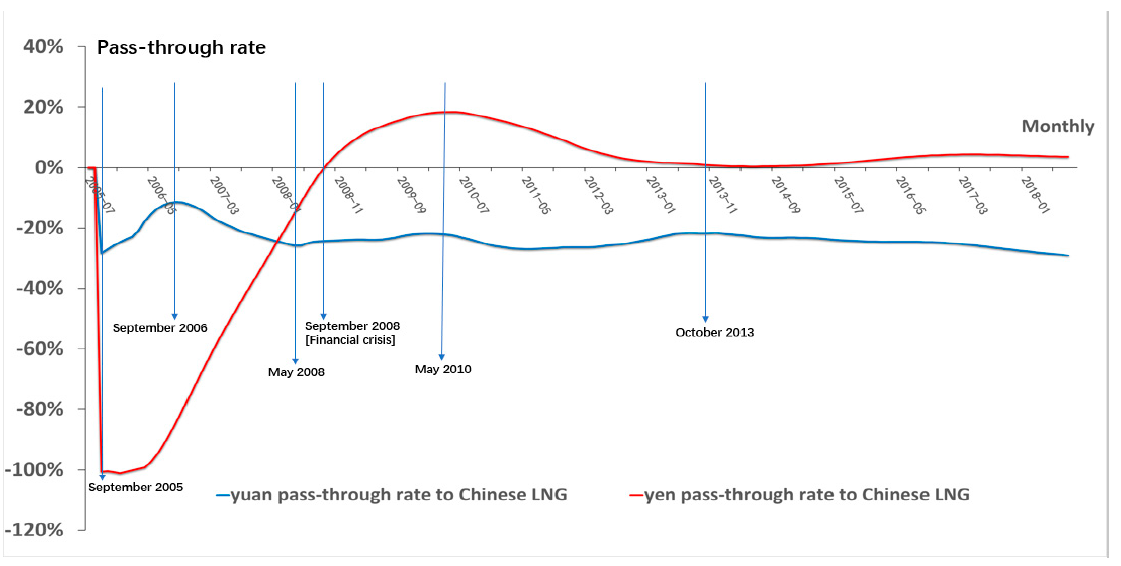
t ,PL t , PJ t ) and JPY ( E2